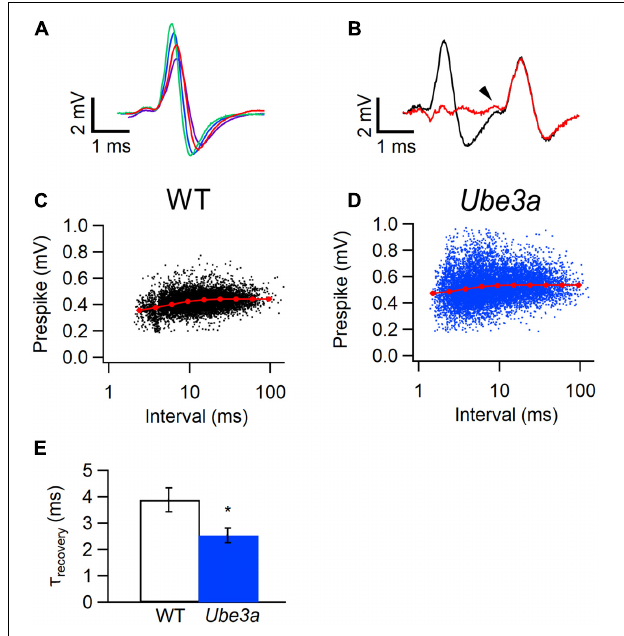
FIGURE 8 | Faster recovery from prespike depression in Ube3a mice. Recordings were made in the juxtacellular configuration. (A) Four templates used for subtraction; each template was made by averaging complex waveforms with similar amplitudes from a recording from a WT mouse (hybrid background). (B) Baseline before (black) and after (red) subtraction of a matching template from the first of the two complex waveforms from the same recording as in A. The prespike is indicated by an arrow head. (C,D) Relation between the amplitudes of the juxtacellularly recorded prespikes